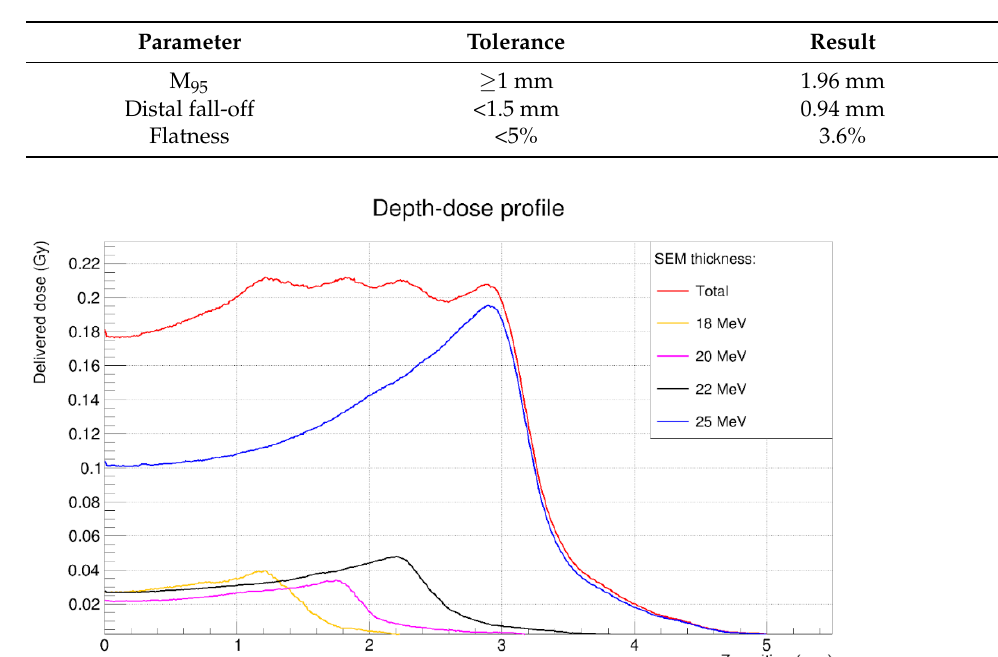
Table 3. Beam quality parameter tolerances and obtained results of the final lateral dose profiles. The calculation of quality parameters is defined in detail in [34,35].